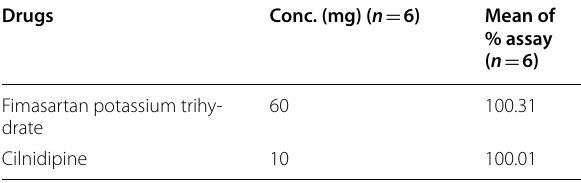
Table 6 Result for change in pH of MP (